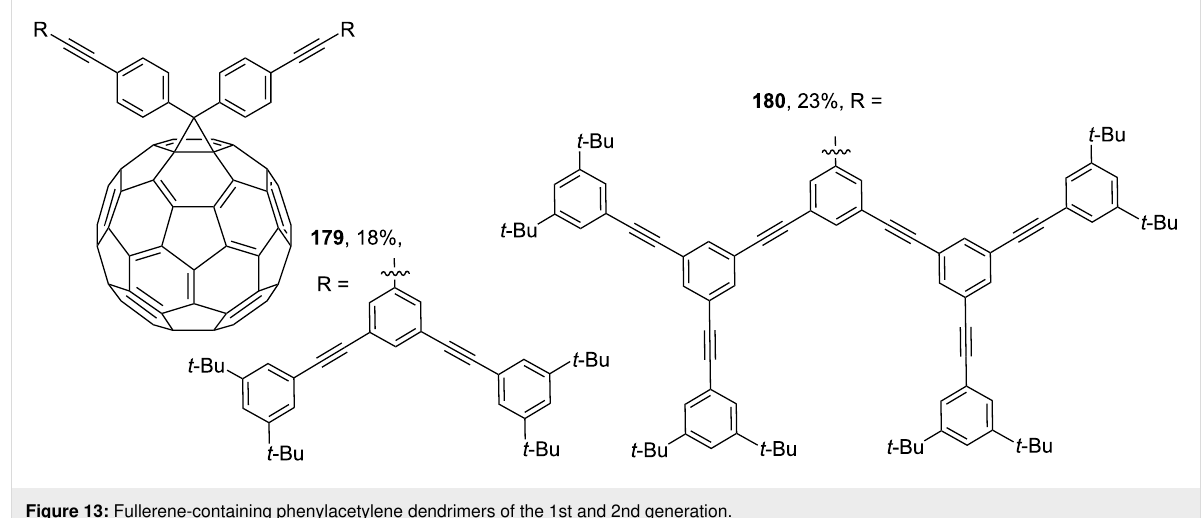
Figure 13: Fullerene-containing phenylacetylene dendrimers of the 1st and 2nd generation.